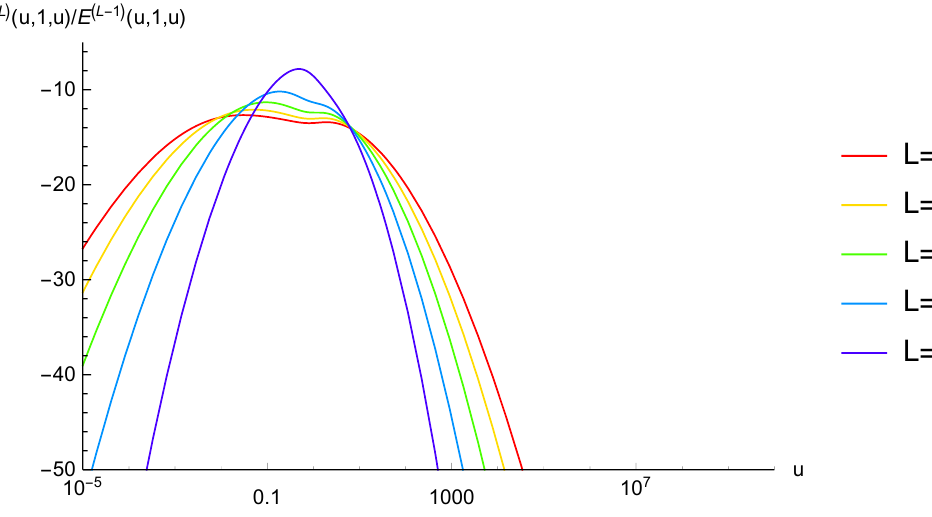
Figure 2 . E ( L ) ( u; 1 ; u ) =E ( L (cid:0) 1) ( u; 1 ; u ) evaluated at successive loop orders.